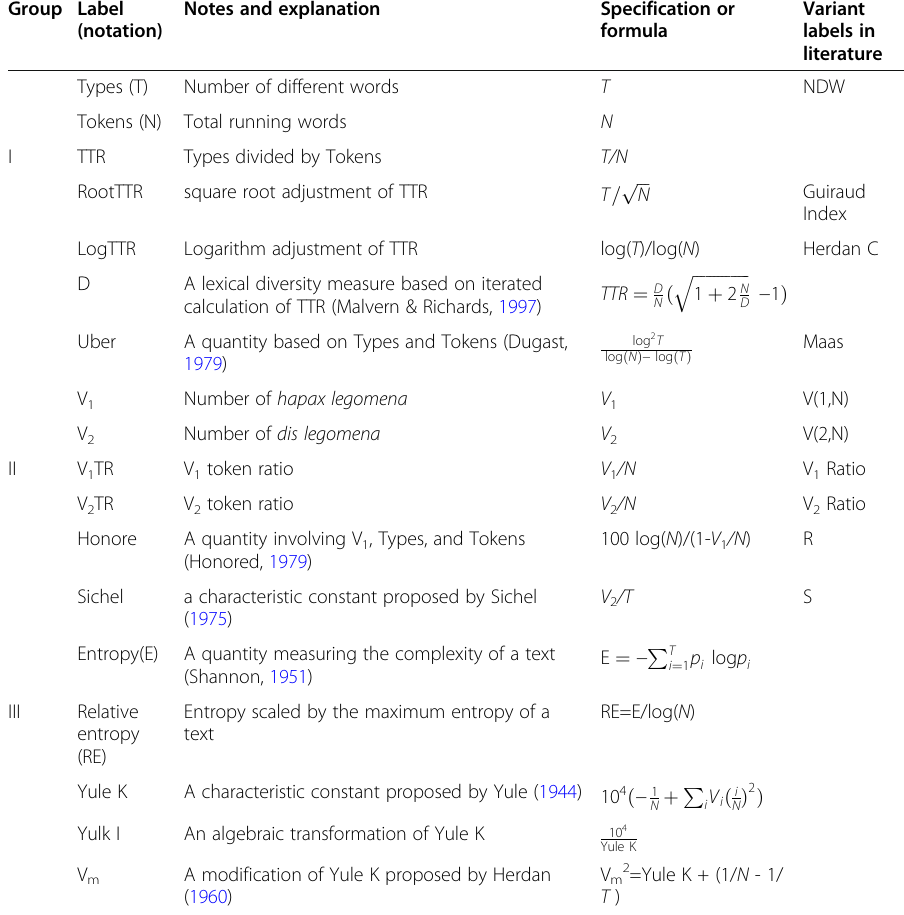
Table 1 LR measures studied in the current paper Group Label Notes and (notation)